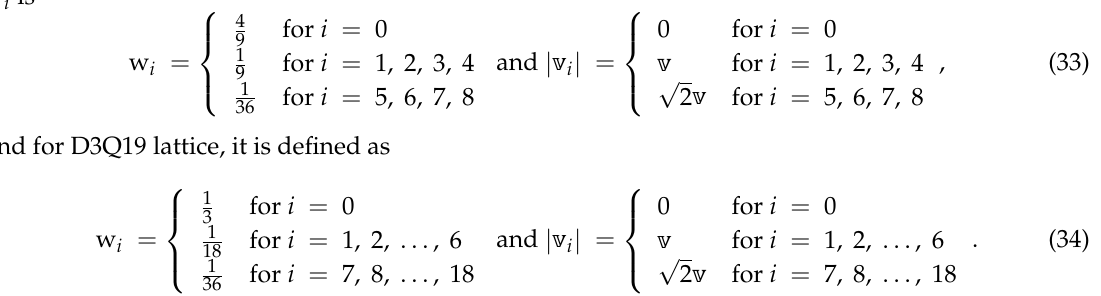
Figure 1. Two typical lattices often used in LB simulations: ( a ) D2Q9; and ( b ) D3Q19.